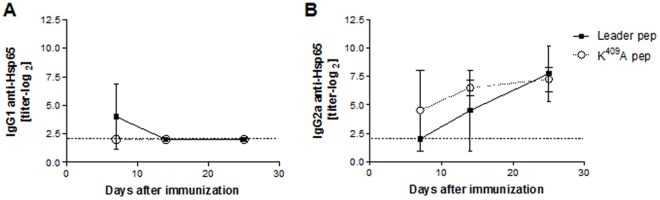
Anti-Hsp65 antibody production in HIII mice.Time-course production of anti-Hsp65 IgG1 [A] and IgG2a [B] antibodies in HIII mice [n = 3 to 5/group] immunized with Leader pep or K409A pep. Antibody titers were evaluated at 7, 14, and 25 days after immunization with synthetic peptides. Results are representative of 2 independent experiments. Dashed lines represent basal levels. Data are expressed as means ± SD.